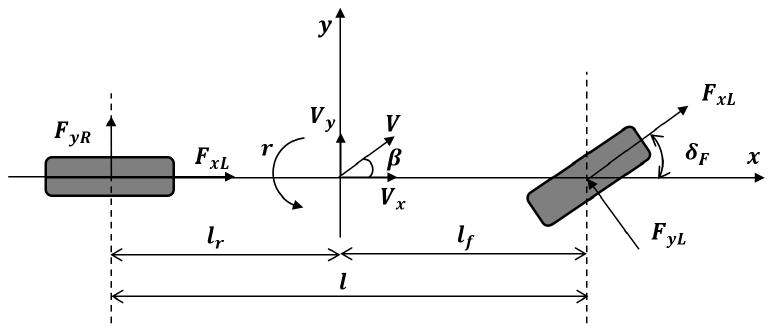
Figure 1. Two-degrees-of-freedom vehicle model.